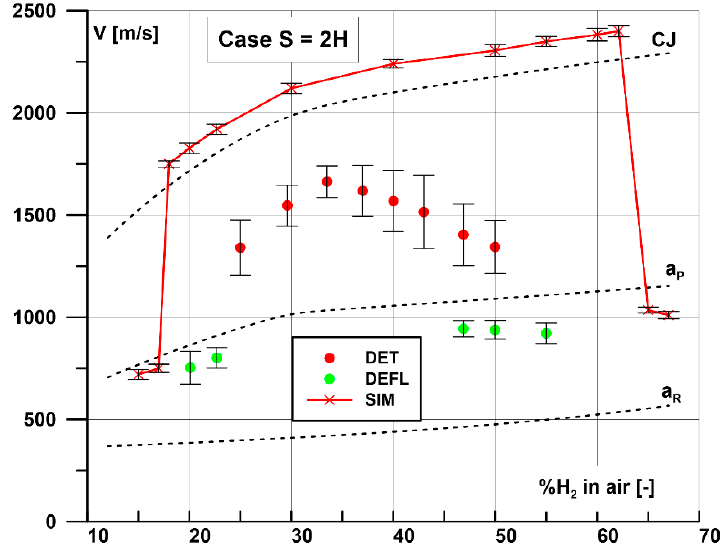
Figure 12. Propagation velocity as a function of mixture composition for S = 2H. Simulation results (line) and experimental results (dots) [31].